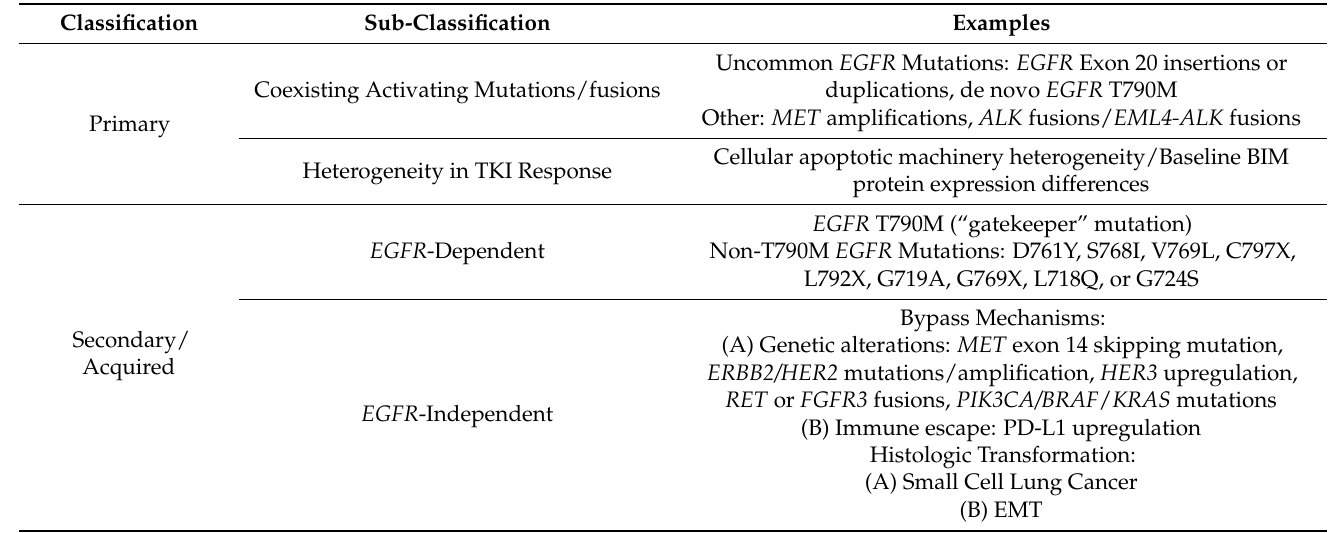
Table 2. Mechanisms of Resistance to